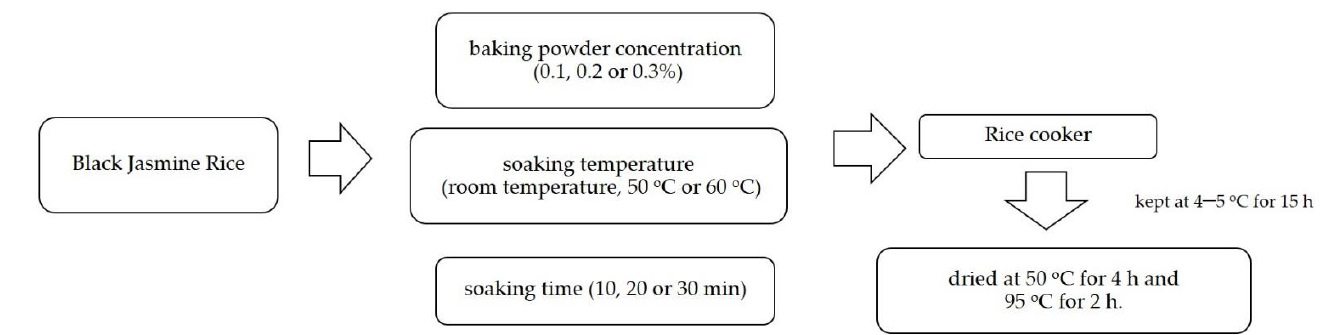
Figure 8. The schematic diagram of Quick Cooking Black Jasmine production in this work.